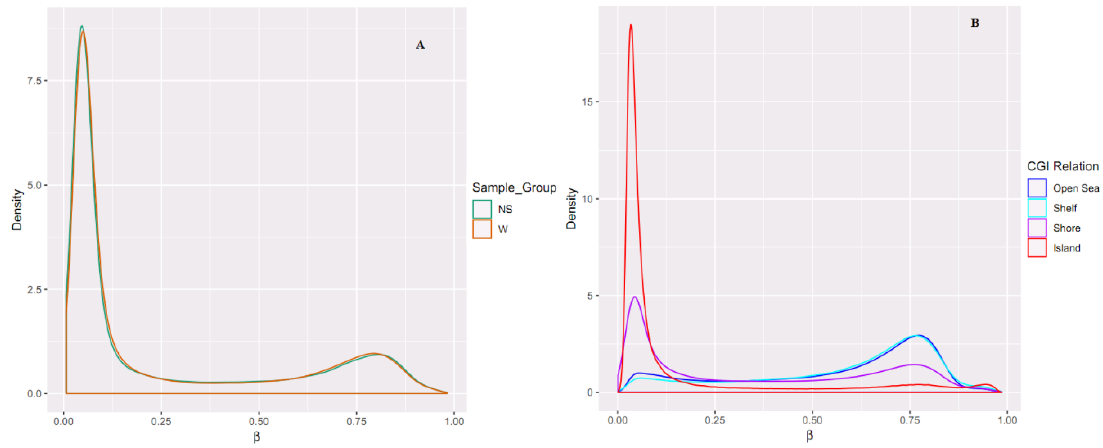
Figure 3. Comparing the density distributions of methylation levels ( β ) in ( A ) W and NS and in ( B ) the CpG content. In ( B ), it can be seen that the island relation has more β value density than other CpG content.